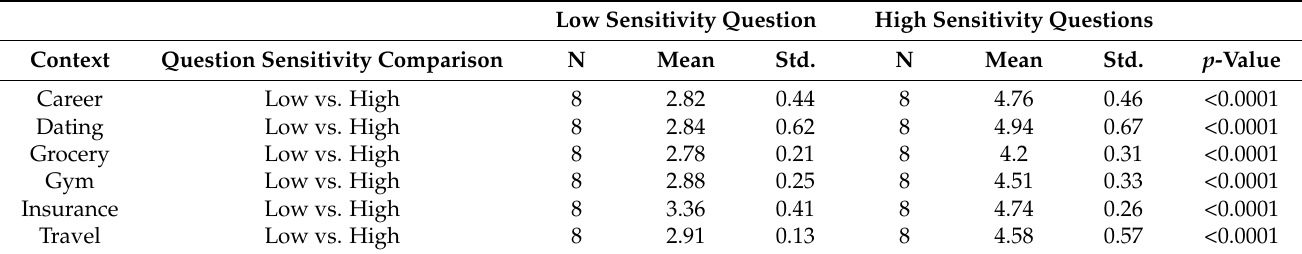
Table 2. Comparison of Low and High Sensitivity Questions Per Context.